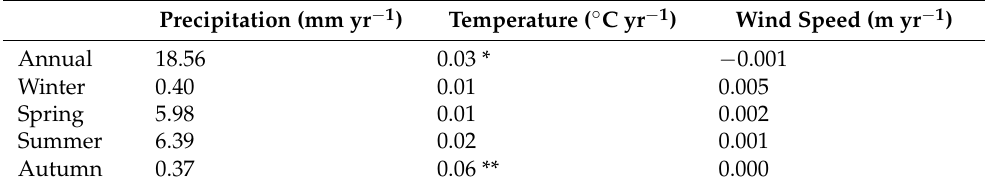
Table 6. Trend rate of ET a , precipitation, air temperature, and wind speed in the MRB from 2000 to